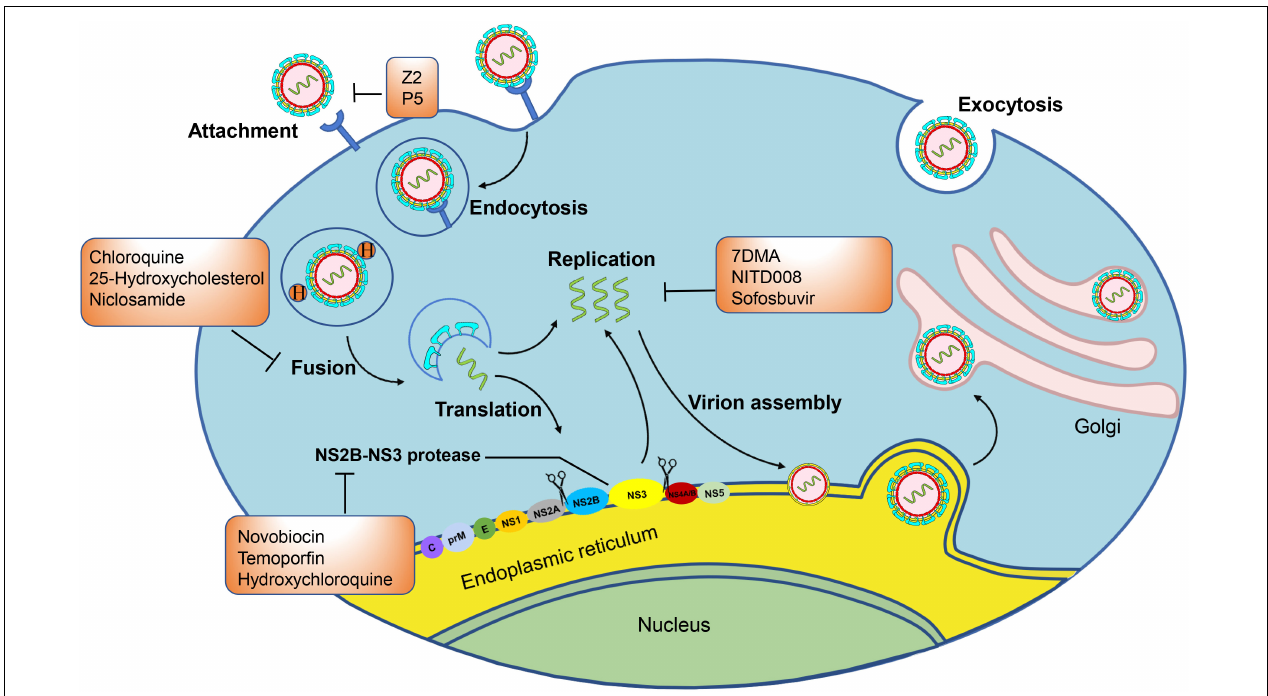
FIGURE 2 | Zika virus infectious life cycle: Host cell membrane receptors bind the E protein of the mature Zika virion, triggering endocytosis. The acidic environment of the endosome induces fusion of the host endosome membrane with the viral envelope and the release of the RNA genome. The RNA is translated into a polyprotein complex, which is cleaved by the host and viral proteases in the ER lumen and cytoplasm, respectively. Following translation, a replication complex is assembled and associated with virus induced membranes where viral replication takes place. The methylated (+) ssRNA, C, E, and prM proteins assemble to form immature virions in the endoplasmic reticulum (ER). The immature virions bud out of the ER into the Golgi apparatus, and they then mature in the trans-Golgi network that are released by exocytosis. In the orange boxes are the names of the compounds that can inhibit the marked steps of the virus lifecycle and that are evaluated in animal models or clinical